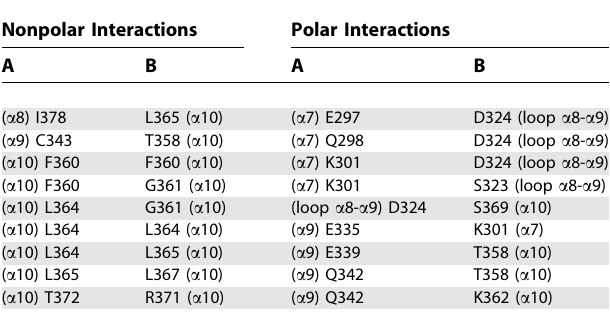
Table 2. Interactions between COUP-TFII A and B Nonpolar Interactions